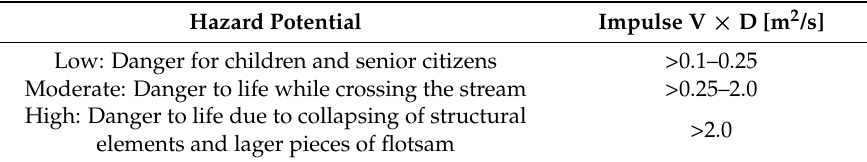
Table 4. Warn criteria for potential danger from flowing water [50,57].